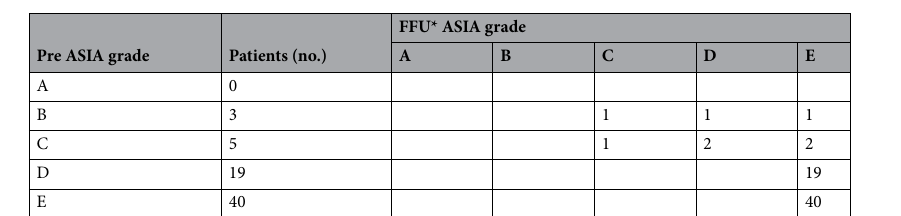
Table 2. The condition of nerve functional restoration. *compare with preoperation P < 0.05. ASIA American Spinal Injury Association, Pre preoperative, FFU final follow-up.